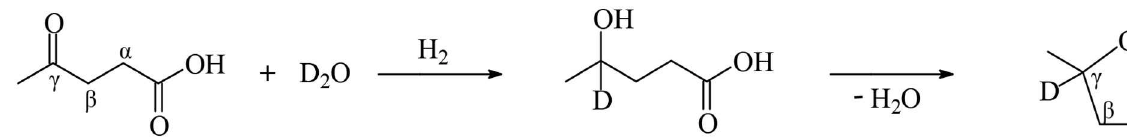
FIGURE 5 | Hydrogenation reaction of LA in D 2 O.